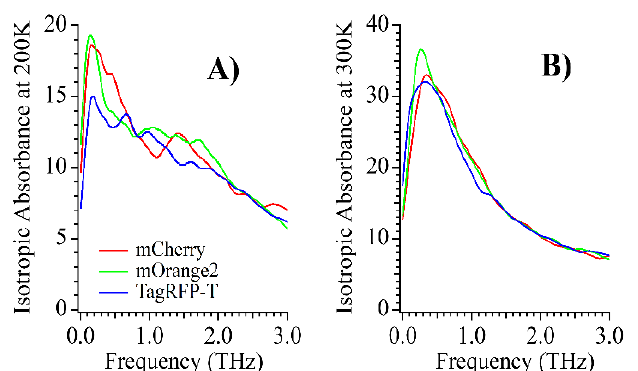
Figure 4. Isotropic THz absorption calculated by quasi-harmonic analysis at 200 K ( A ) and 300 K ( B ). High temperature absorption shows a Lorentzian-like peak centered at ~0.5 THz for all three RFPs. The same color scale is used for both plots.